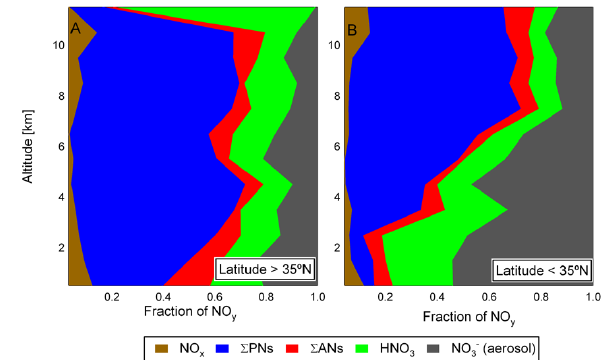
Fig. 2. Median vertical profile in ozone (black) and gas-phase NO y Figure 2 : Median vertical profile in ozone (black) and gas-phase NO y (grey) (NO y ≡ NO x + 553 (grey) (NO y ≡ NO x + 6 PNs + 6 ANs + HNO 3 ) as observed dur- PNs + ANs + HNO 3 ) as observed during the INTEX-B field campaign over the North Pacific 554 during the Spring of 2006 (April-May), North of 35ºN left panel and South of 35ºN right panel . 555 ing the INTEX-B field campaign over the North Pacific during the The solid line depicts the median value in 1 km altitude bins and the shaded regions represent the 556 Spring of 2006 (April–May), North of 35 ◦ N (left panel) and South interquartile range. 557 of 35 ◦ N (right panel). The solid line depicts the median value in 558 1km altitude bins and the shaded regions represent the interquartile range.